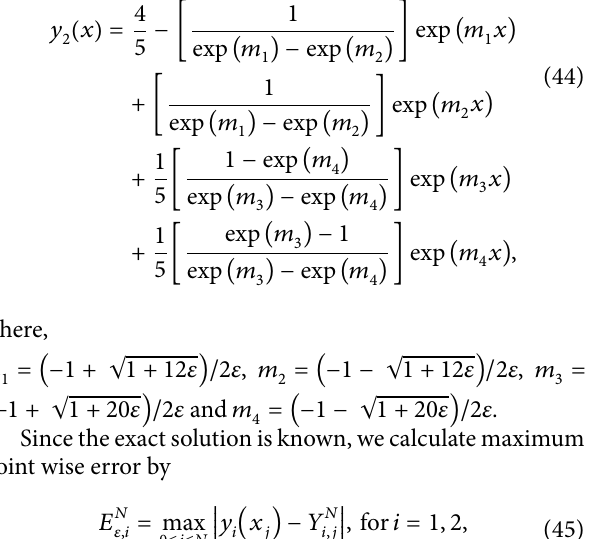
Figure 1: Plot of the exact and approximate solutions of Example 9 and . for 푁 = 1024 휀 = 0.01